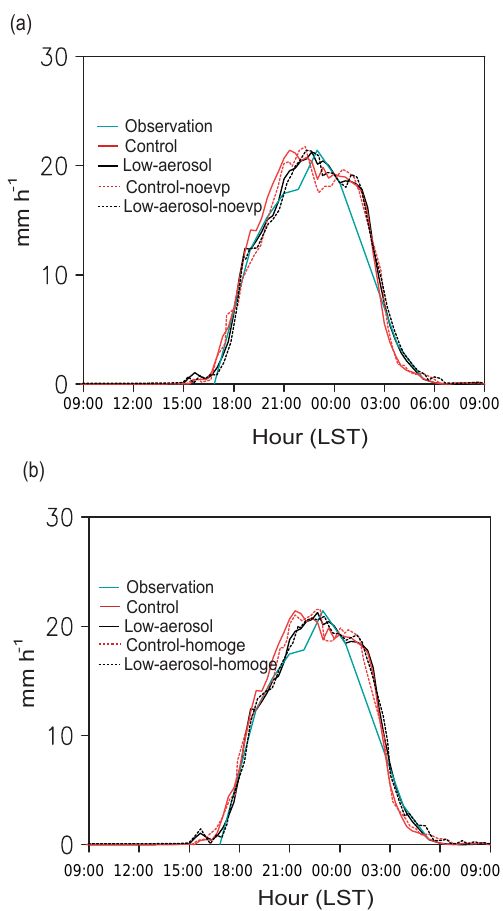
Figure 6. Time series of the area-mean precipitation rates at the surface smoothed over 3h for the control run, the low-aerosol run, and observations in Domain 3. In panel (a) , the rates in the control- noevp run and the low-aerosol-noevp are additionally shown, while in panel (b) , the rates in the control-homoge run and the low- aerosol-homoge are additionally